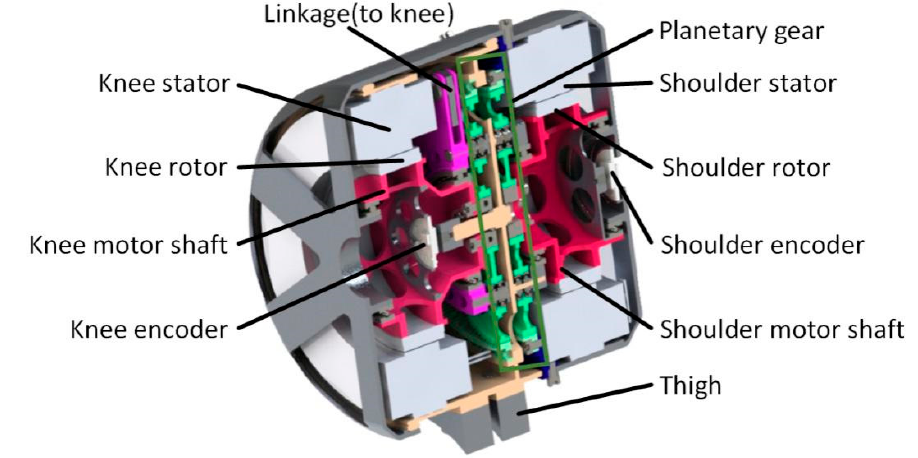
Figure 7. Detailed design of the shoulder module.